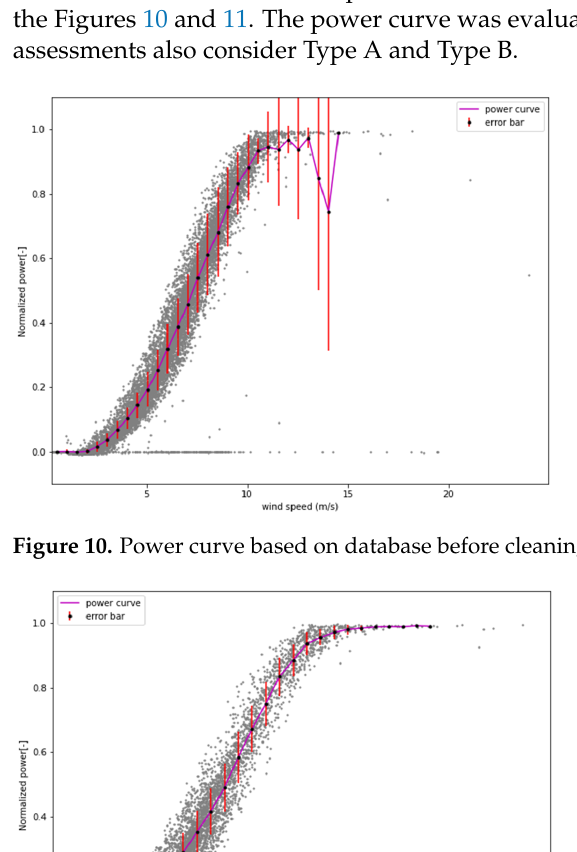
Figure 9. Schematic diagram of installing sensors at different heights of met mast.